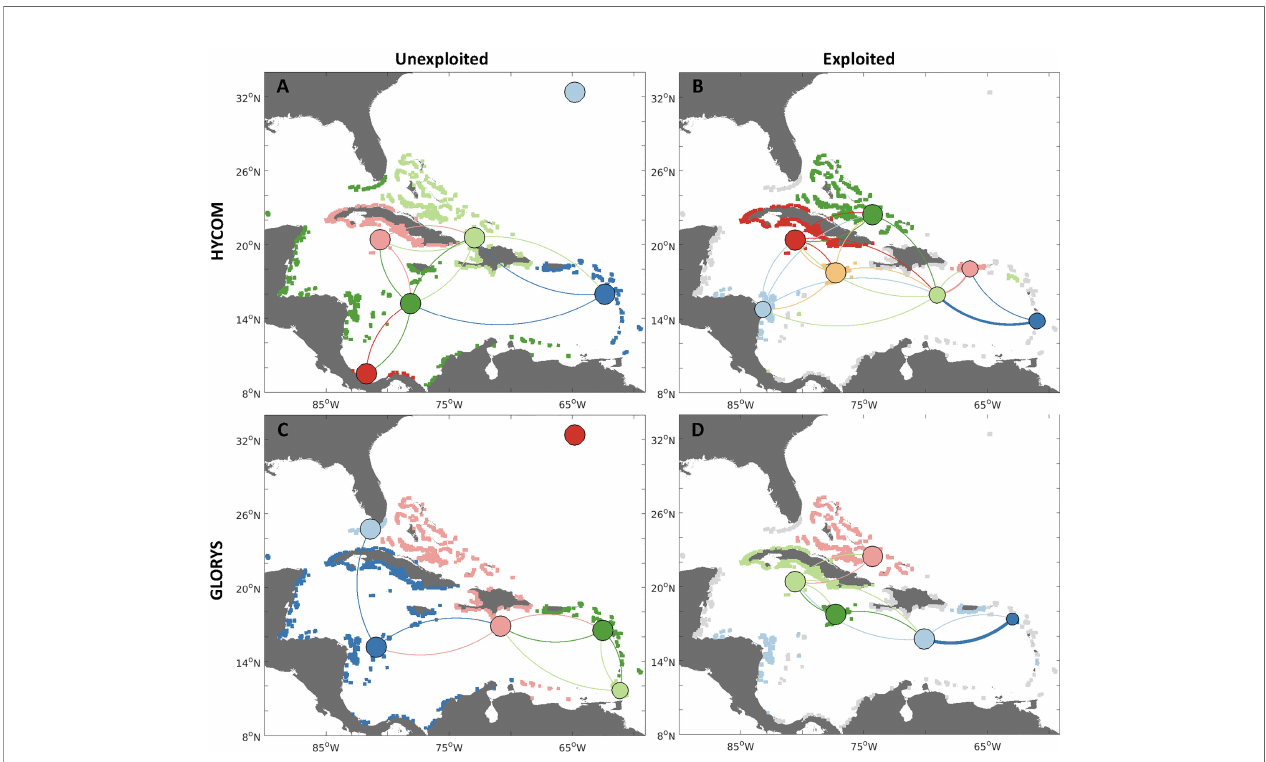
FIGURE 7 | Connectivitynetworkanalysesforqueenconchmetapopulationsidenti fi edwithaminimizationalgorithm(Jacobietal.,2012;Garavellietal.,2014),fortwodifferent reproductiveoutputscenarios:1)unexploited, i.e. ,uniformspawningforallhabitatpolygons( A,C leftcolumn);and2)exploited,orspawningscaledbymedianadultdensities reportedperjurisdiction( B,D rightcolumn).Metapopulationsareidenti fi edbythehabitatpolygoncolors(grayhabitatrepresentsnonreproductivepopulations, i.e. ,whereno spawningoccurs).LarvaearedispersedwithHYCOMvelocities( A,B, toprow),andGLORYS12v1reanalysis( C,D, bottomrow).Edgesbetweennodesrepresentthestrength ofconnectionsbetweenregions,wherebythedirectionoflarval fl owisgivenbytheclockwisedirection-concaveedgesrepresentexportwhileconvexrepresentsimport.Node sizesrepresenttheprobabilityofself-settlement-theirlocationisgivenbythemeanlatitudeandlongitudeofallhabitatpolygonsinthatspeci fi cmetapopulation.Colorsvary betweenscenarios,sincethenumberandcon fi